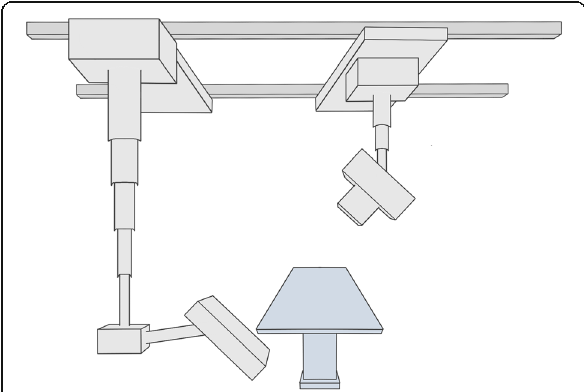
Fig. 2 The prototype cone-beam computed tomography scan mode is based on a radiography system with two telescopic arms mounted on ceiling rails. One arm carries the x-ray tube, while the other holds a large flat panel detector. Simultaneous arm movement along predefined trajectories allows for three-dimensional